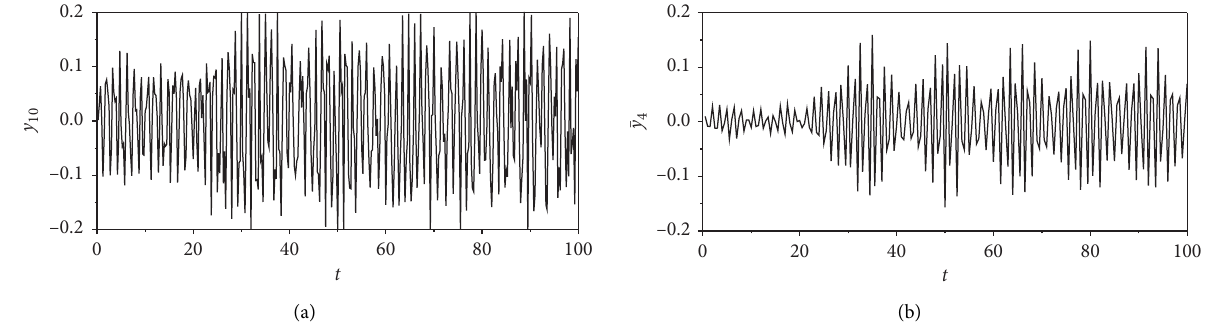
2 when Ω 4 ≈ ω 2 , 4 .